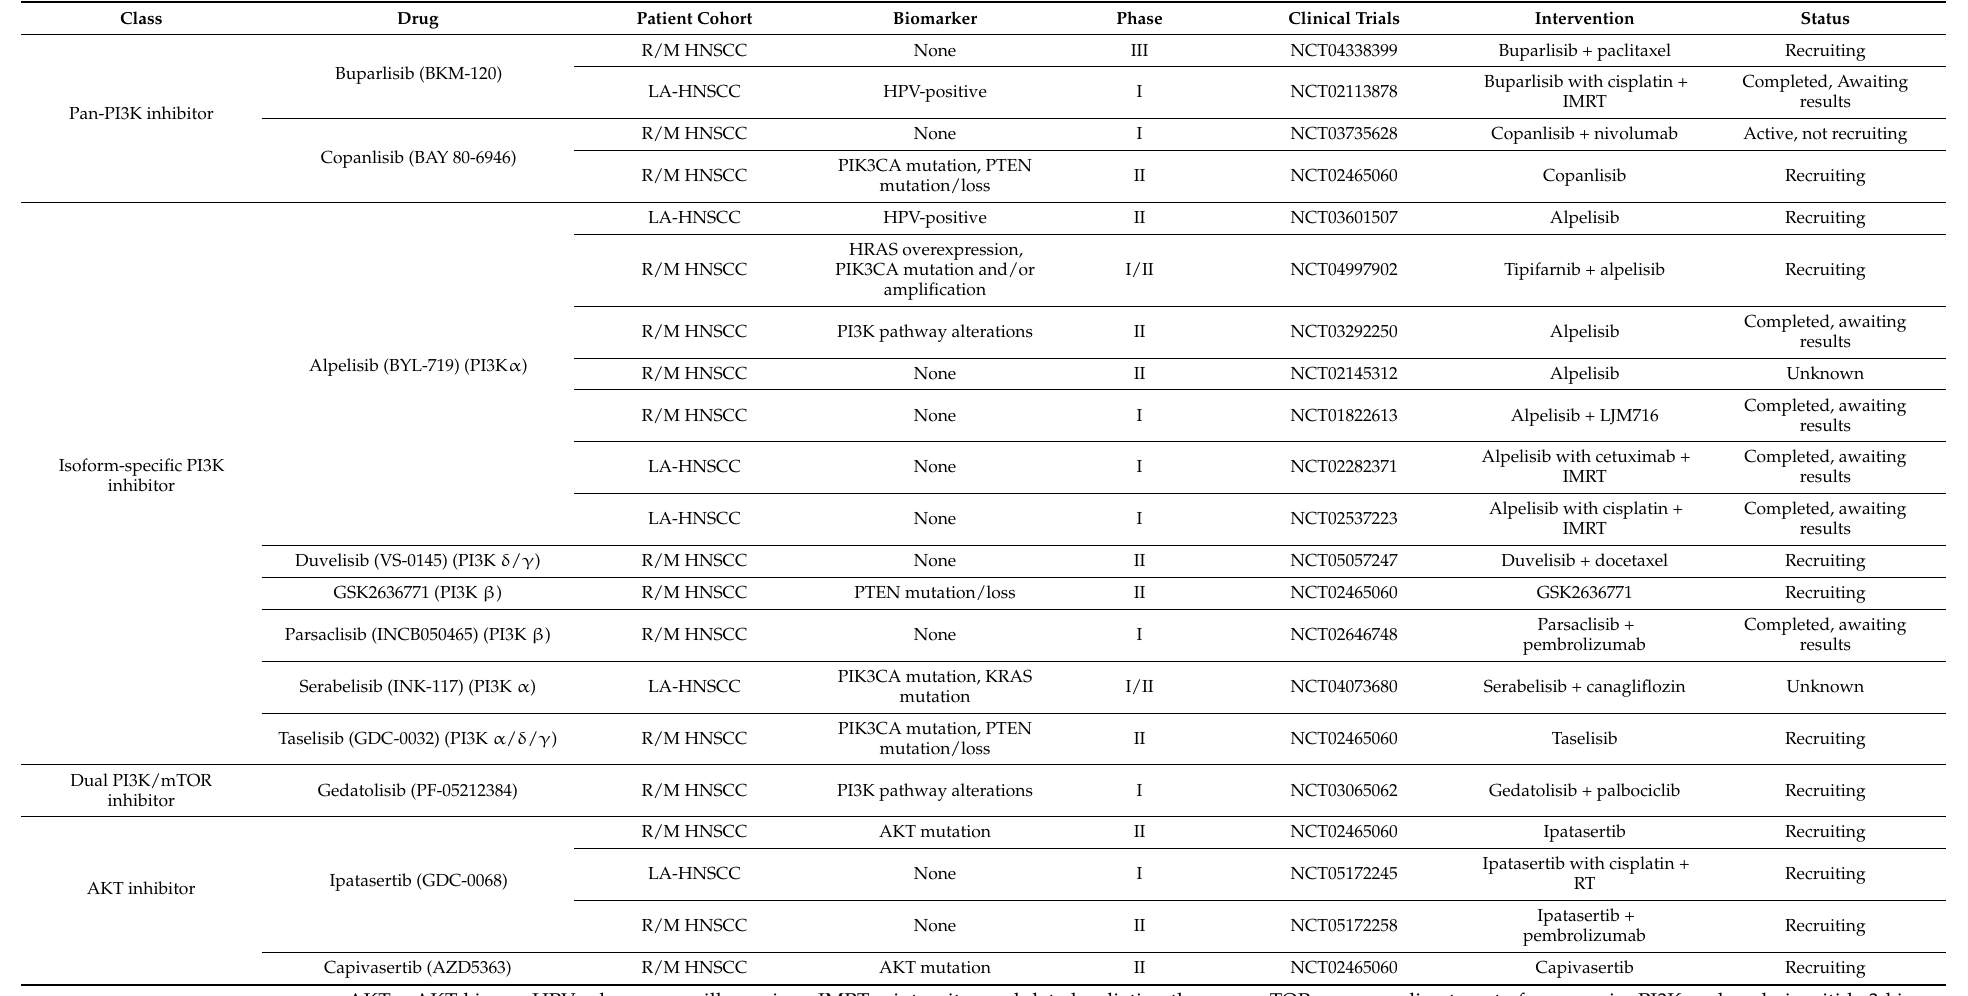
Table 1. Ongoing clinical trials with PI3K/AKT/mTOR inhibitors in